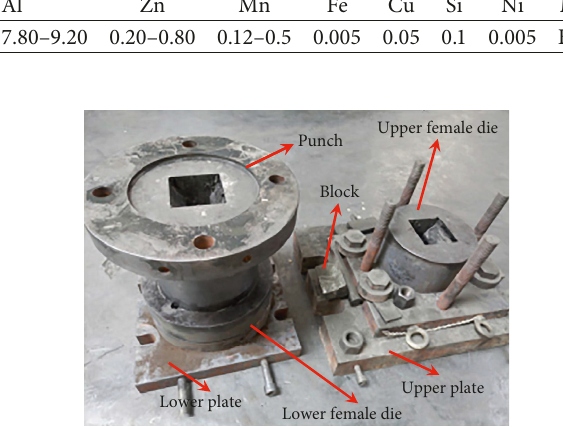
Figure 1: Drawing of the CEE die.